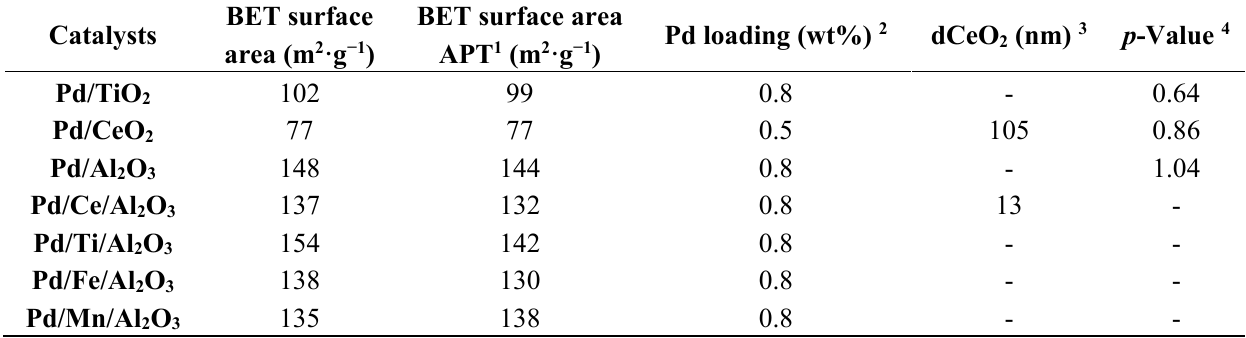
Figure 1. ( a ) N 2 adsorption/desorption isotherms and ( b ) pore size distributions associated with CeO 2 , Al 2 O 3 and TiO 2 supports. Table 2. Physicochemical properties of the Pd supported